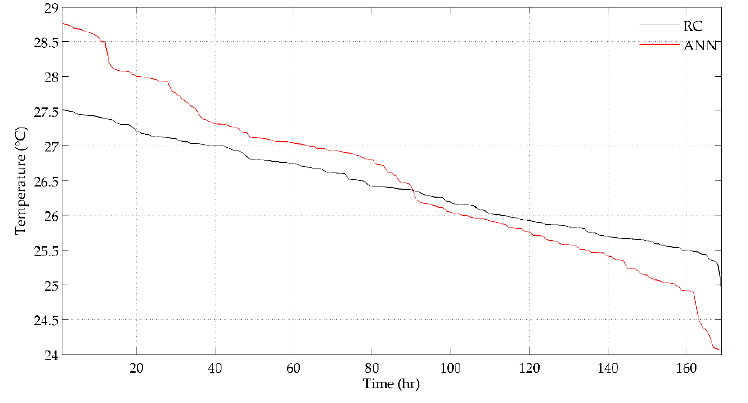
Figure 10. MPC with RC as building prediction model: ( a ) internal air temperature, comparison between the actual Type 56 air zone temperature, and RC prediction at each timestep; ( b ) cooling power profile (control action sequences). Figure 11. Indoor air temperature duration curves.